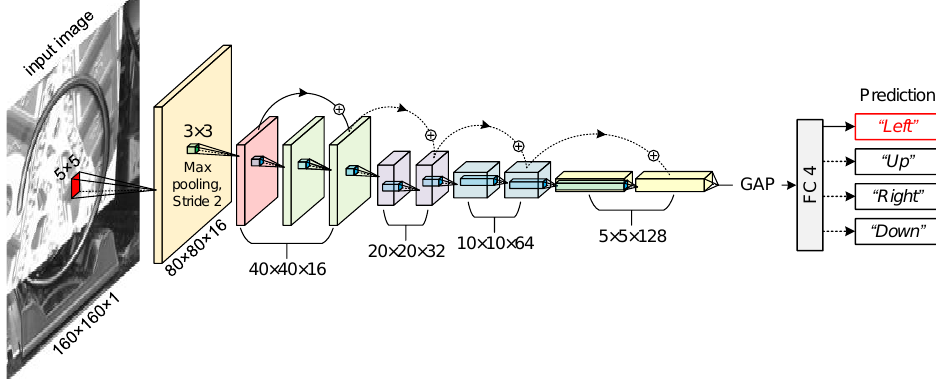
Figure 3. Network architecture with feature maps of sizes {80, 40, 20, 10, 5}, and an example of the inference process. The image is labeled as “Left” and predicted as